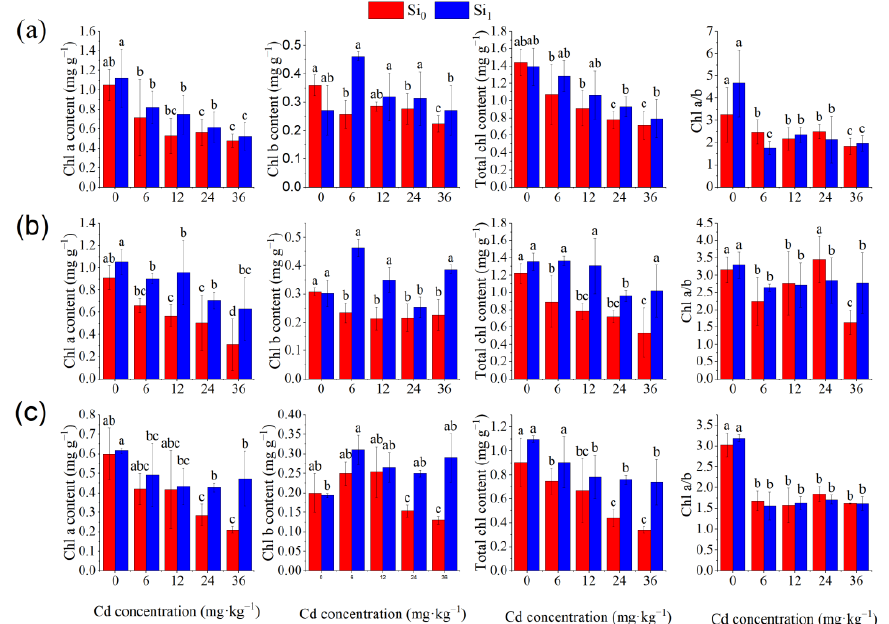
Figure 4. Effects of Cd and Si on chlorophyll a, chlorophyll b, total chlorophyll and chlorophyll a/b ratio of seedling for ( a ) Schima superba , ( b ) Chinese sweetgum, and ( c ) Chinese firs. Each value is a mean of six repetitions. Lowercase letters above the bars indicate significant differences according to the Turkey’s test ( p < 0.05).